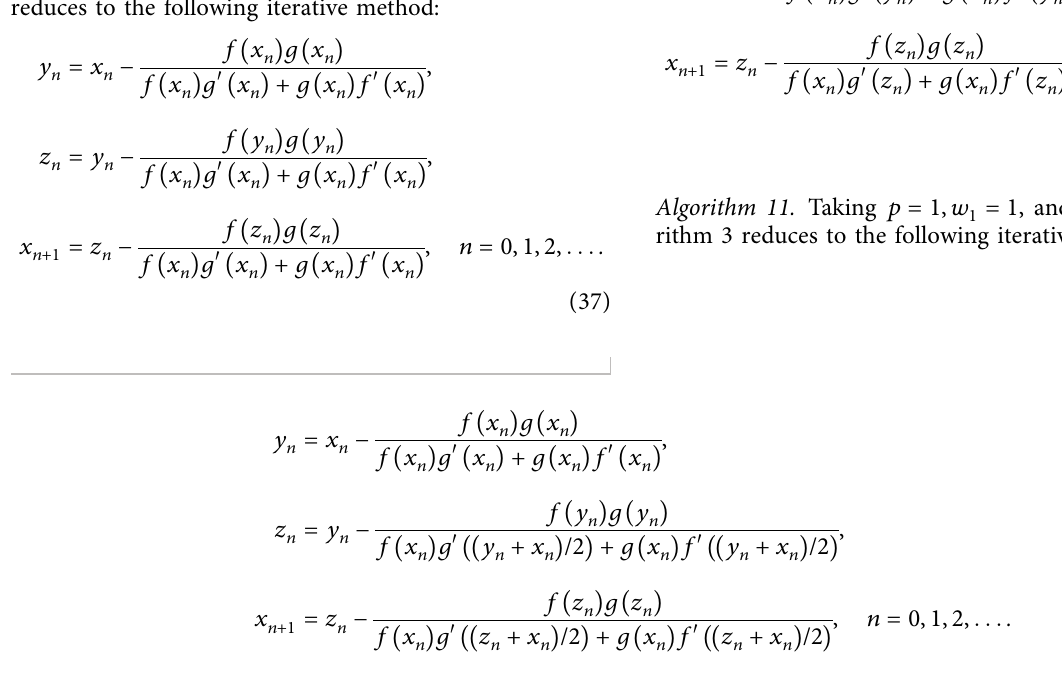
� 1, and τ � 0, Algorithm 3 1 1